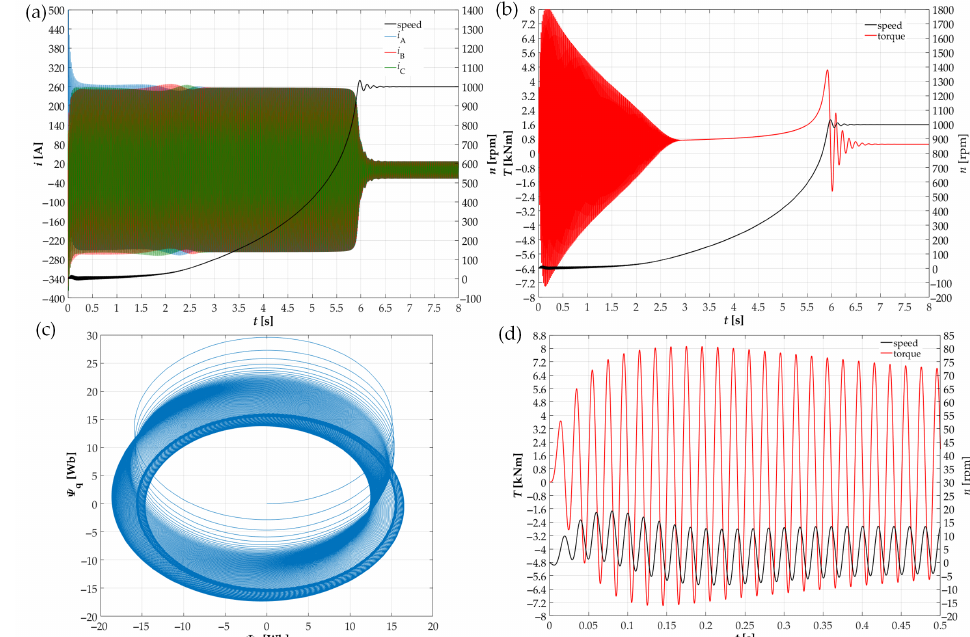
Figure 9. Waveforms of physical quantities for direct start-up, with no voltage phase delay and constant load torque T o = 500 Nm: ( a ) time waveforms of the stator currents in three phases and rotational speed; ( b ) time waveform of the electromagnetic torque and rotational speed; ( c ) hodograph of stator fluxes; ( d ) segment of the time waveform of the electromagnetic torque and rotational speed at the first moment of starting.